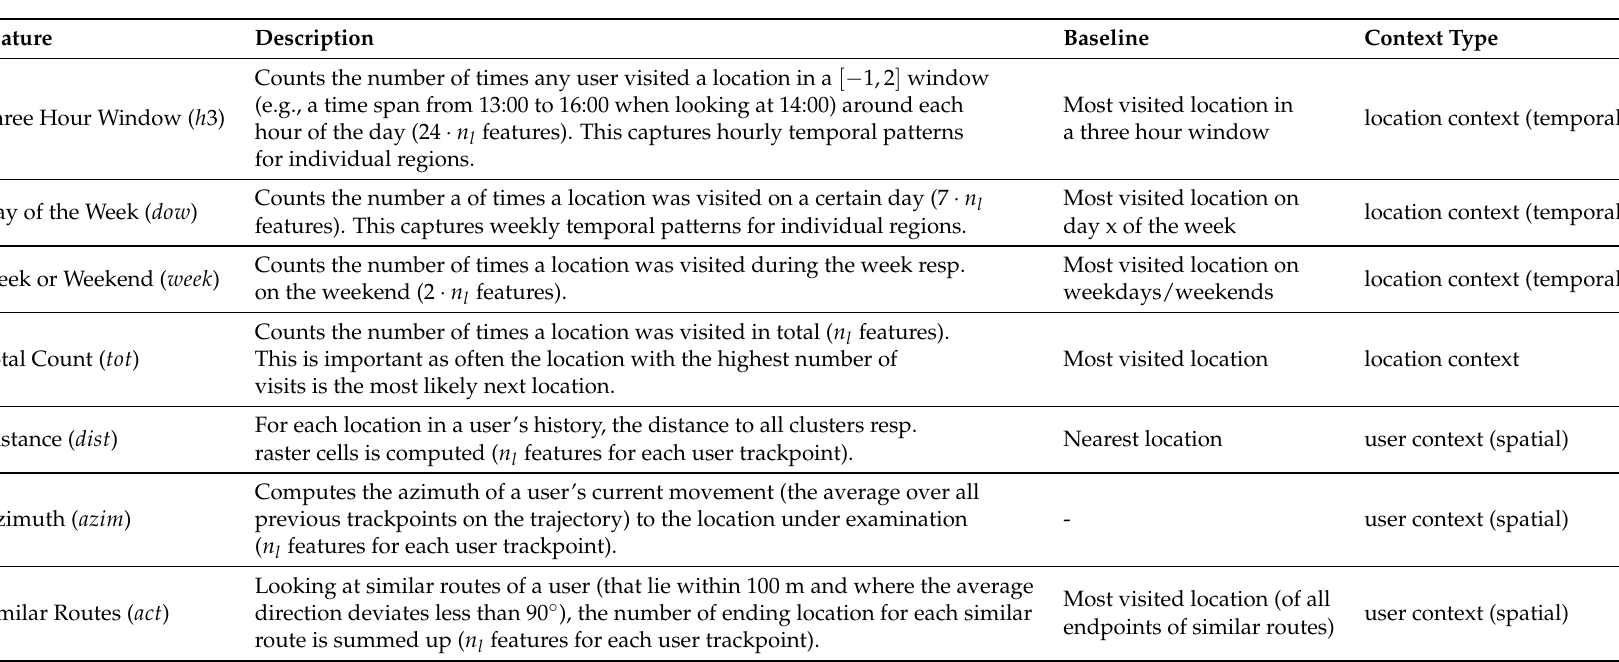
Table 1. Different machine learning input features extracted from the user location histories. The baseline methods are derived from these features by building a model that always predicts the location with the highest feature count. In the table, the number of locations is denoted as n l